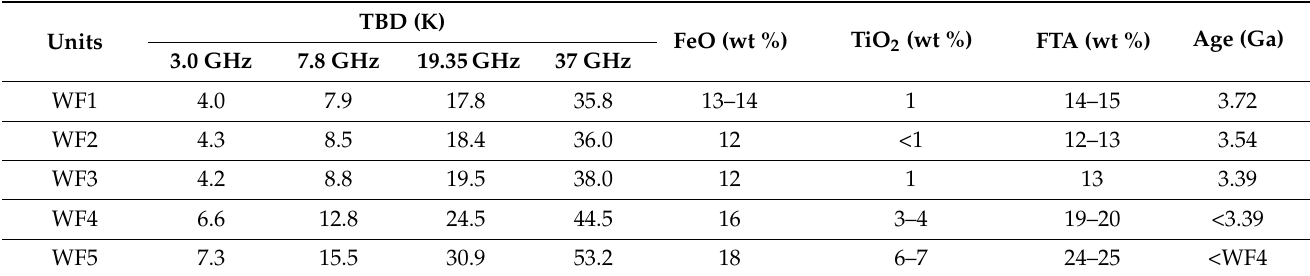
Table 1. The SCREP-based FeO, TiO 2 , and FTA values mapped by Kramer et al. [2] and the four- channel TBDs of the WF1, WF2, WF3, WF4, and WF5